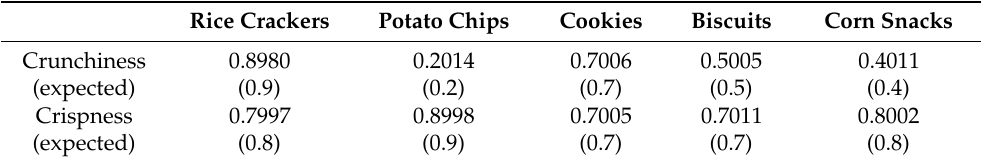
Table 3. Averages of texture values in the estimation result data store.